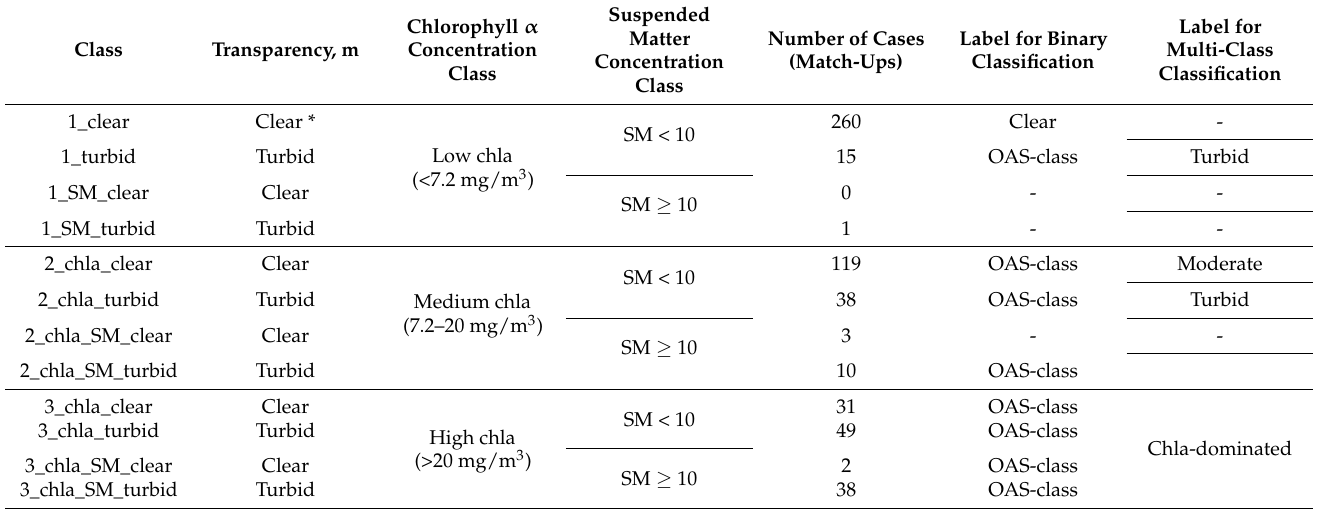
Table 1. The definition of classes for a binary (2) classification problem—differentiation of a Clear class from those with higher amounts of optically active substances (OAS-class). Classes with—notation were not included in the training-test set due to small number of observations in